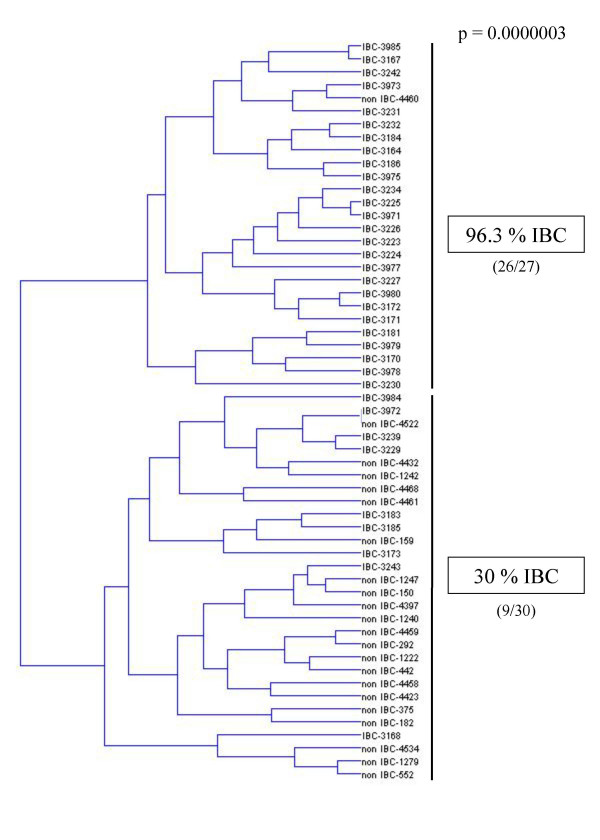
Dendrogram of the 35 IBCs and the 22 non IBC samples, constructed using hierarchical clustering, according to the expression of 6 genes, i.e. TNFAIP3/A20, SELE, COX2, CXCL12, CCND3, and IER3L. This analysis revealed two groups of tumors with 96,3% (26/27) of IBCs clustered in one group and 30% (9/30) in the second group.